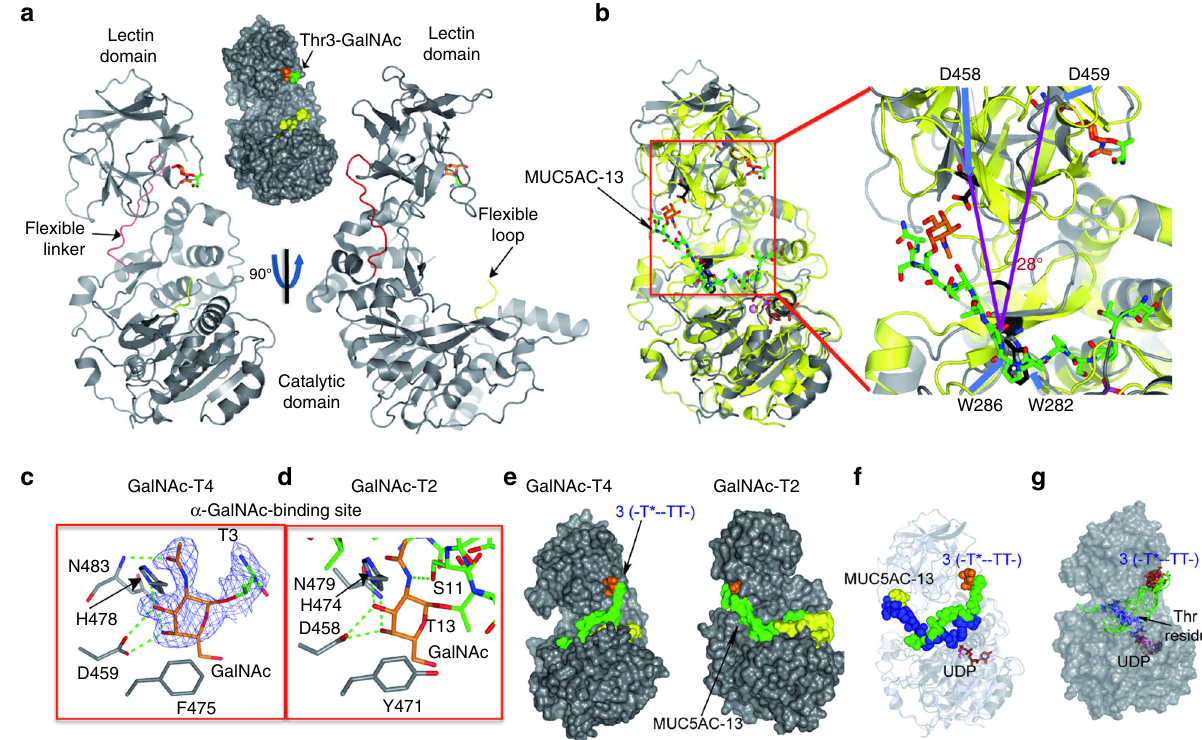
Fig. 3 Structural characterization of the interaction between GalNAc-T4 and monoglycopeptide 3. a Two different views of GalNAc-T4 in complex with 3 . The catalytic and lectin domains are colored in gray and the interdomain fl exible linker is depicted in red. The catalytic domain fl exible loop is depicted in yellow and is mostly disordered. The GlcNAc moiety of the Thr3-GalNAc is shown as orange carbon atoms while Thr3 is shown as green carbon atoms. b (left) Superposition of the GalNAc-T4-glycopeptide 3 (gray) and GalNAc-T2-MUC5AC-3-UDP-Mn +2 (yellow) structures. The glycopeptide and the GalNAc moiety are shown in green and orange carbon atoms, respectively. The lectin α -subdomain GalNAc-binding residues, Asp458, and Asp459, of GalNAc-T2 and GalNAc-T4 are shown as sticks in black and gray carbon atoms, respectively. (right panel) Close-up view of the superposition between GalNAc-T2 and GalNAc-T4. Colors for peptides, GalNAc moiety, and proteins are identical as shown above. c – d Close-up view of the lectin α -subdomain GalNAc-binding site for both GalNAc-T4 (left) and T2 (right). The residues of both enzymes are depicted as gray carbon atoms. Hydrogen bond interactions are shown as dotted green lines. Electron density maps are F O – F C (blue) contoured at 2.2 σ for Thr3-GalNAc. Note that both GalNAc-binding sites are depicted in the same orientation for comparison. e Surface representation of GalNAc-T4 (model built with monoglycopeptide 3 and UDP/Mn +2 ), and GalNAc-T2 (with UDP/Mn +2 /MUC5AC-13). Both are viewed from the same orientation as in b . Colors for the glycopeptide and the fl exible loop are the same as above. f Superposition of the GalNAc-T4-glycopeptide 3 -UDP-Mn +2 (gray) and GalNAc-T2-MUC5AC-3-UDP-Mn +2 (blue – white) structures. The glycopeptide and the GalNAc moiety in the structure of GalNAc-T2 and GalNAc-T4 are shown as spheres in blue/green and yellow/orange, respectively. UDP and Mn +2 are shown as brown carbon atoms and as a pink sphere, respectively. g Superimposed structures of the 200 ns MD simulation trajectory for GalNAc-T4 in complex with glycopeptide 3 /UDP/Mn +2 . GalNAc-T4 is depicted in a light gray surface view. The GalNAc moiety, the peptide backbone, UDP, and the acceptor Thr residues are shown as orange, green, brown, and blue carbon atoms,